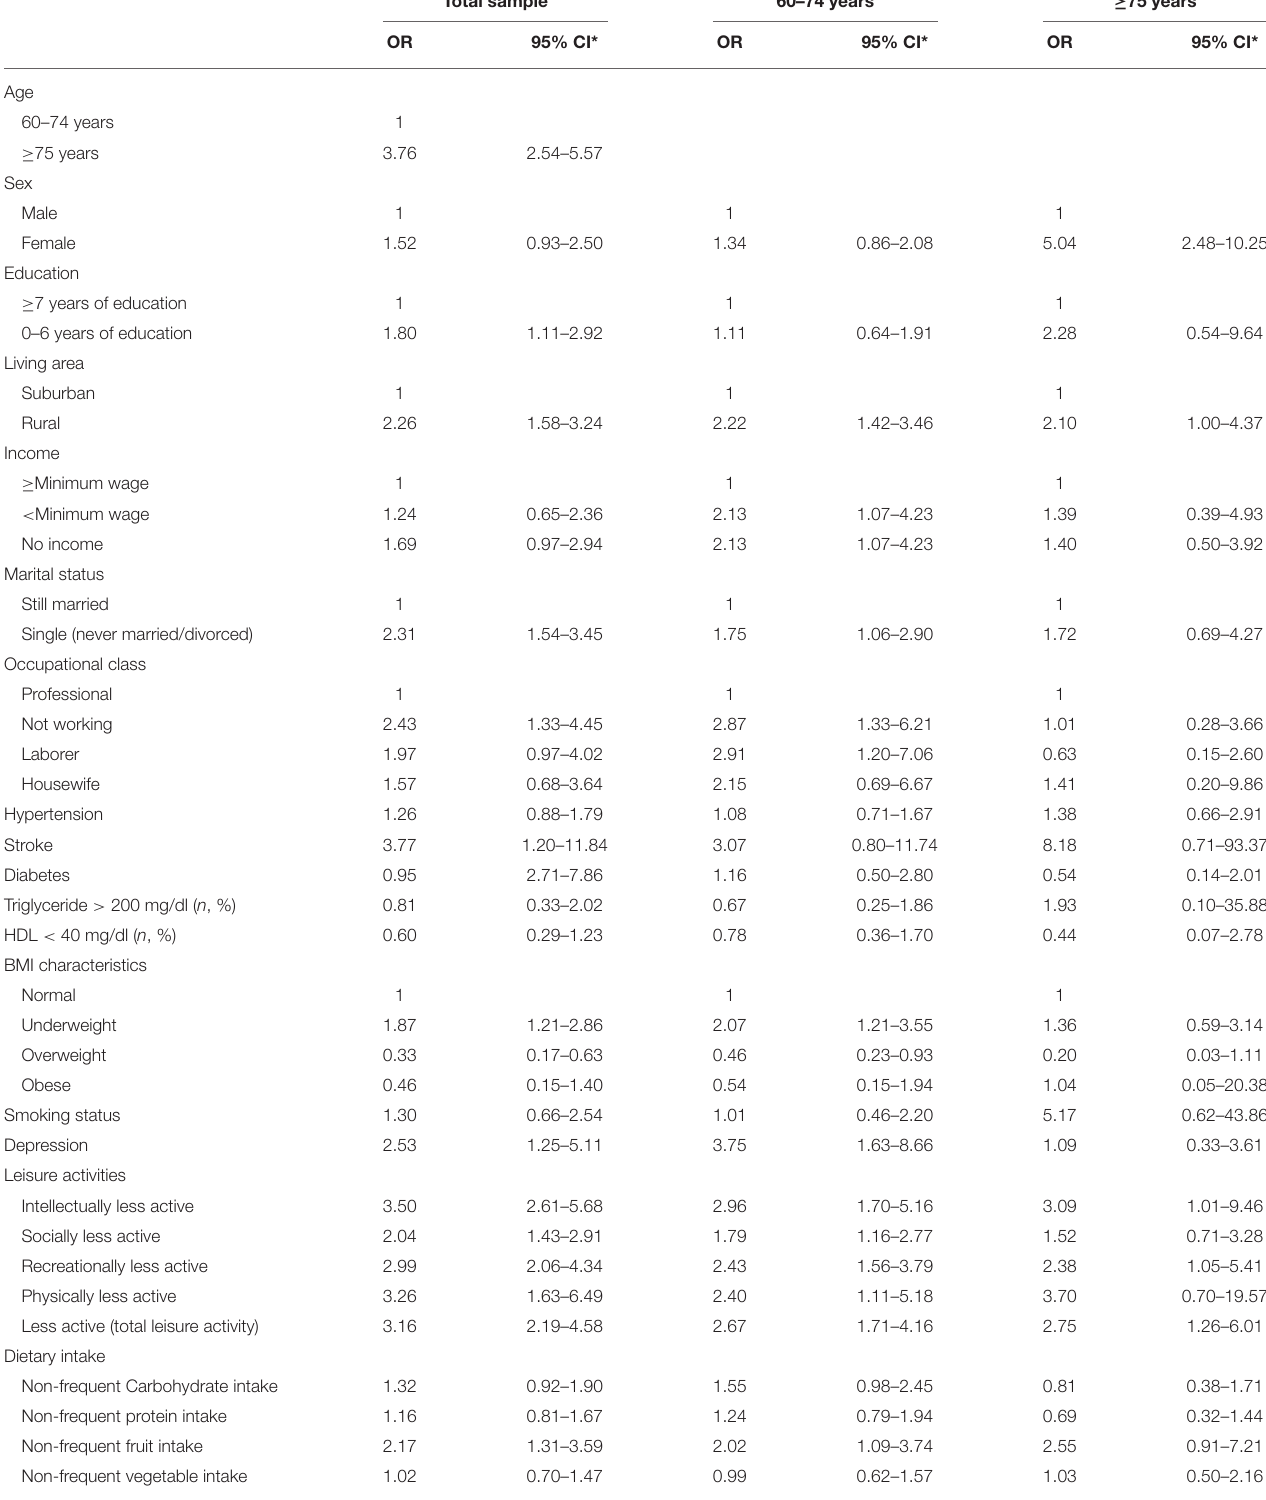
TABLE 2 | Univariable associations between potential risk factors and dementia in the total sample ( n = 686) and stratified by